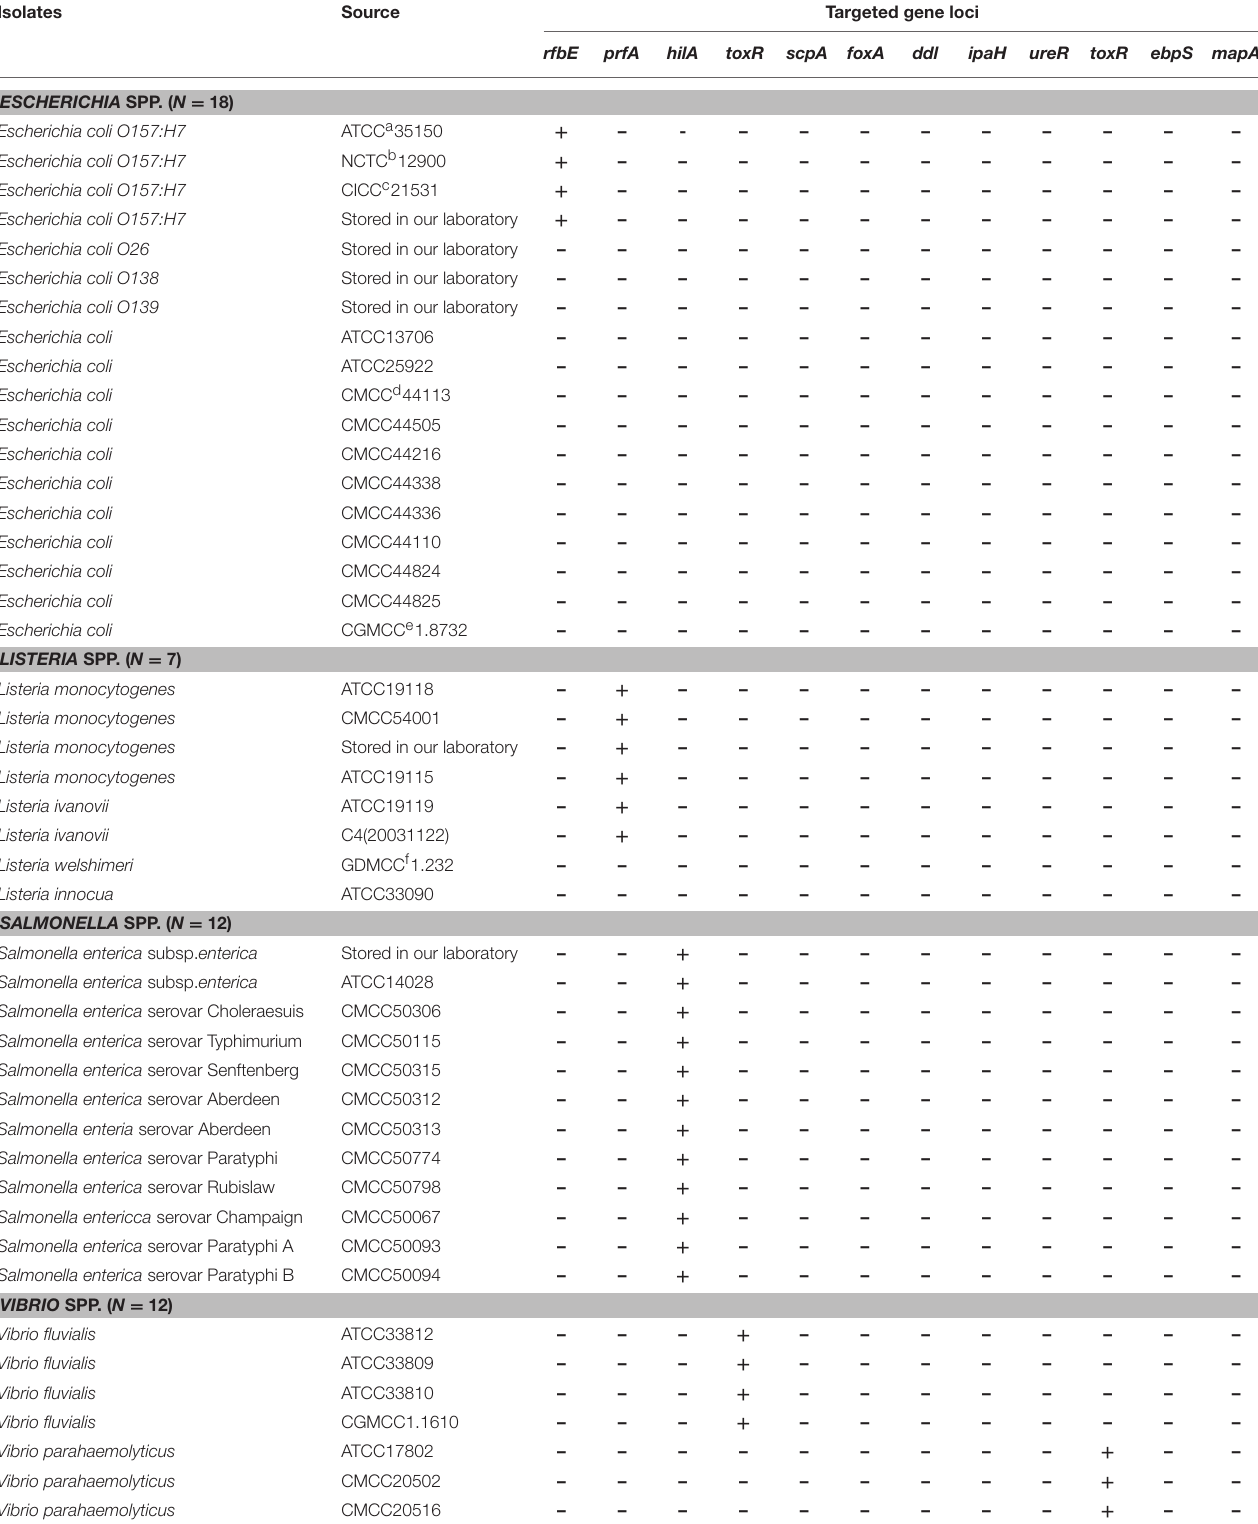
TABLE 2 | Tested isolates and results for the real-time PCR.